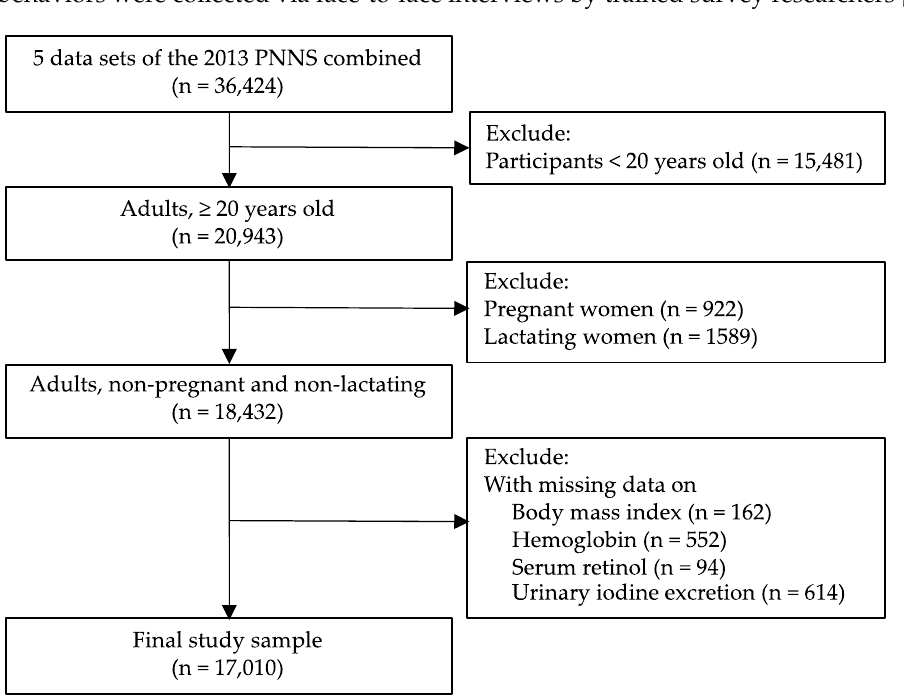
Figure 1. Flowchart of participant selection.